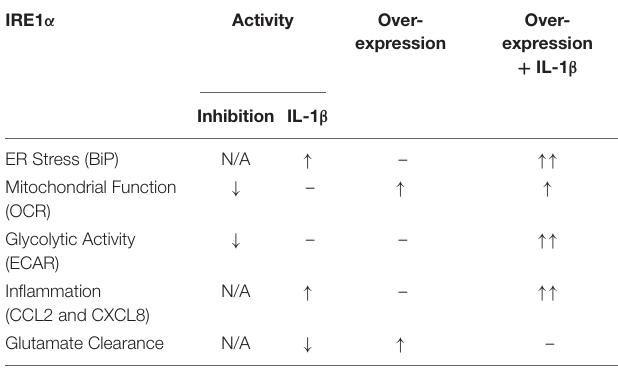
TABLE 1 | Astrocyte IRE1 α regulates ER stress, mitochondrial respiration, glycolysis, inflammation, and glutamate clearance. IRE1 α